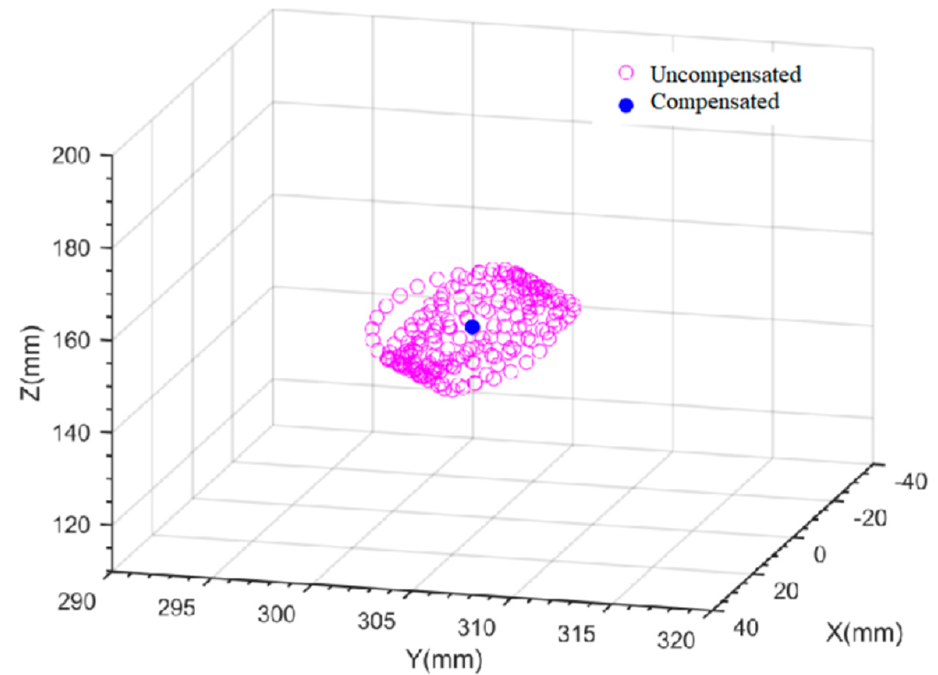
Figure 23. Comparison between uncompensated and compensated end effector trajectories when the ship is equipped with a controllable passive anti-rolling tank.